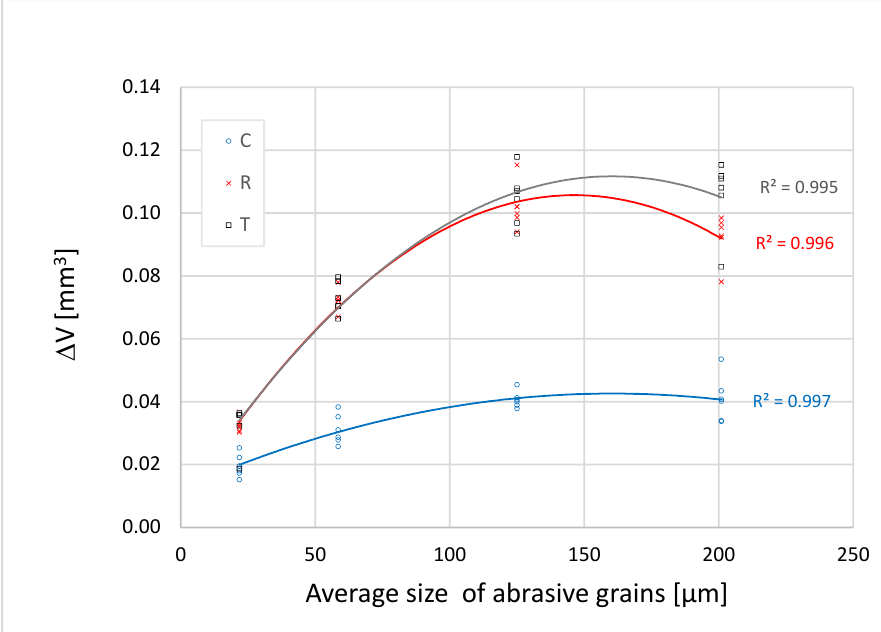
Figure 7. Dependence of the abrasion volume loss in Sample 3 on the average size of abrasive grains.